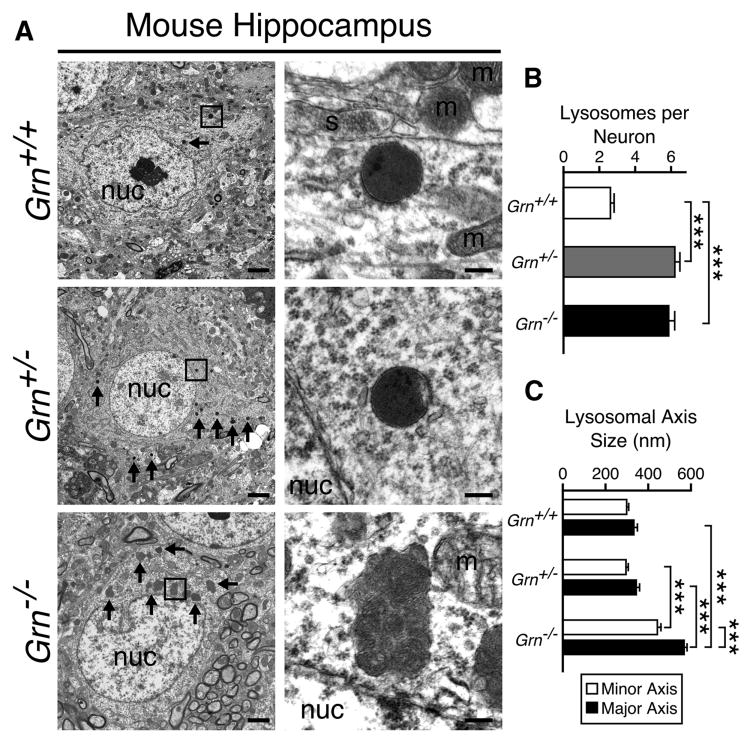
Loss of PGRN Induces Abnormal Lysosomal Morphology and Abundance in Mouse Neurons(A) Representative electron micrographs of hippocampal sections from 3-month-old Grn+/+, Grn+/−, and Grn−/− mice. Lysosomes (inset boxes in left panels) are shown at higher magnification in right panels. Arrows indicate lysosomes. m, mitochondrion; nuc, nucleus; s, synapse. Scale bars represent 2 μm (left panels) and 200 nm (right panels).(B and C) Analysis of hippocampal lysosomes from Grn+/+, Grn+/− and Grn−/− mice (n = 3 mice per genotype; 20 neurons per mouse; two-tailed Student's t test; ***p < 0.001). Data are presented as mean ± SEM. (B) Quantification of lysosomes per hippocampal neuron is shown. (C) Quantification of lysosomal morphology from (B) as measured by the longest (major) and shortest (minor) axes is shown.